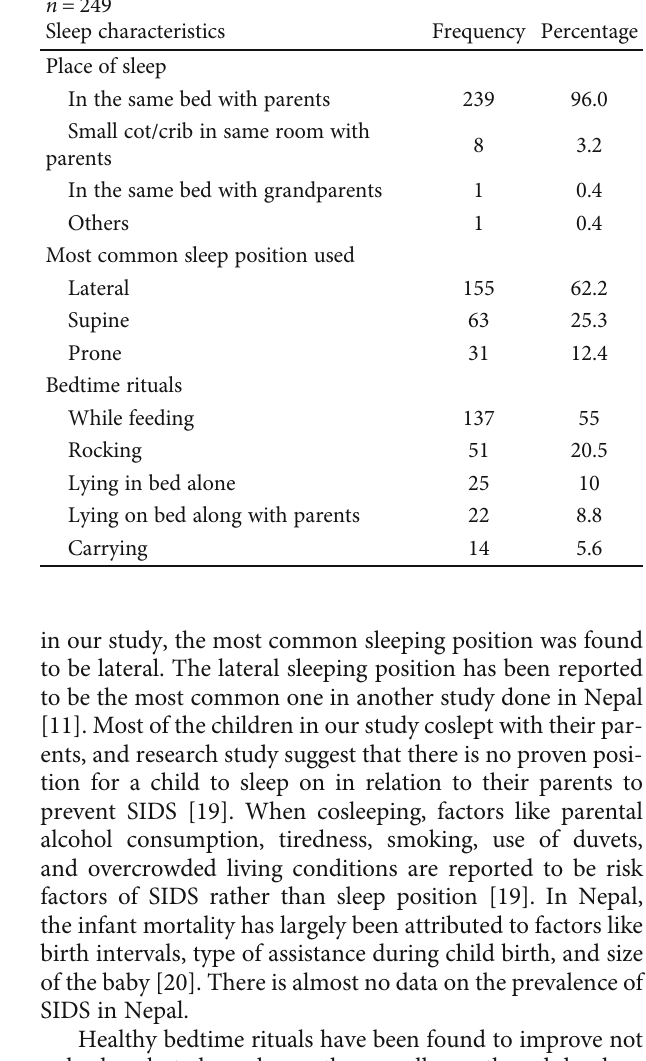
Table 1: Sociodemographic characteristics of the respondents and child.